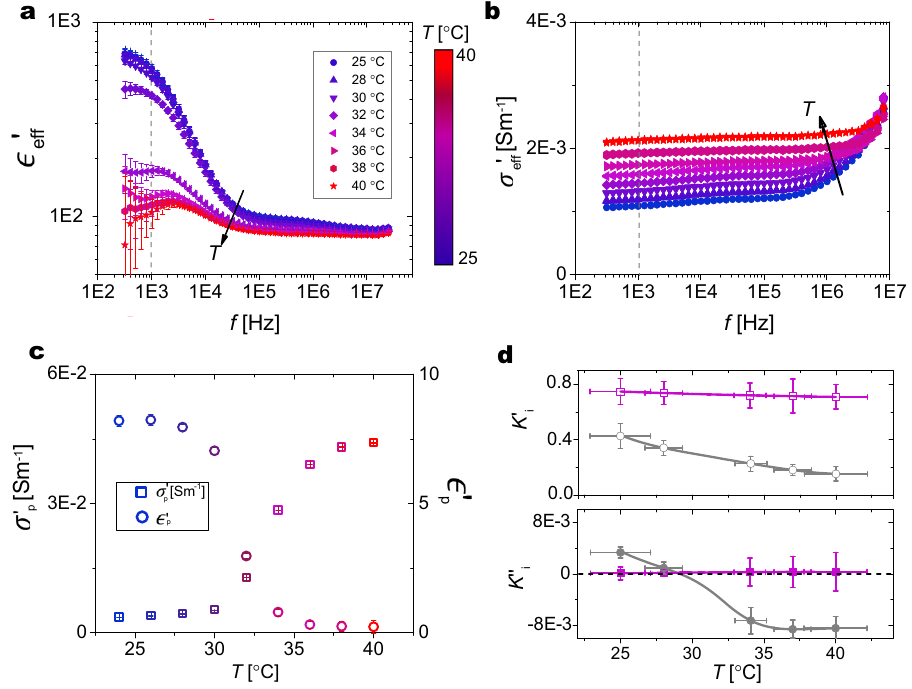
and b σ 0 as a function of frequency f for an aqueous suspension of microgels (1 wt %) measured for T Fig. 3 Dielectric spectroscopy measurements. a ϵ 0 eff eff between 22 and 40 °C. The data are corrected to remove electrode polarization. c Permitivitty ( ϵ 0 p, open circles) and conductivity ( σ 0 p, open squares) vs. T at f = 1 kHz. d Real ( K 0 top, open symbols) and imaginary part ( K ″ bottom, solid symbols) of the Claussius – Mossotti factor for each particle i , i.e., microgels (gray) and PS particles (pink). The values are obtained for each particle from Eq. (2), using the corresponding values of σ 0 p and ϵ 0 p. The error bars indicate the standard deviation of the